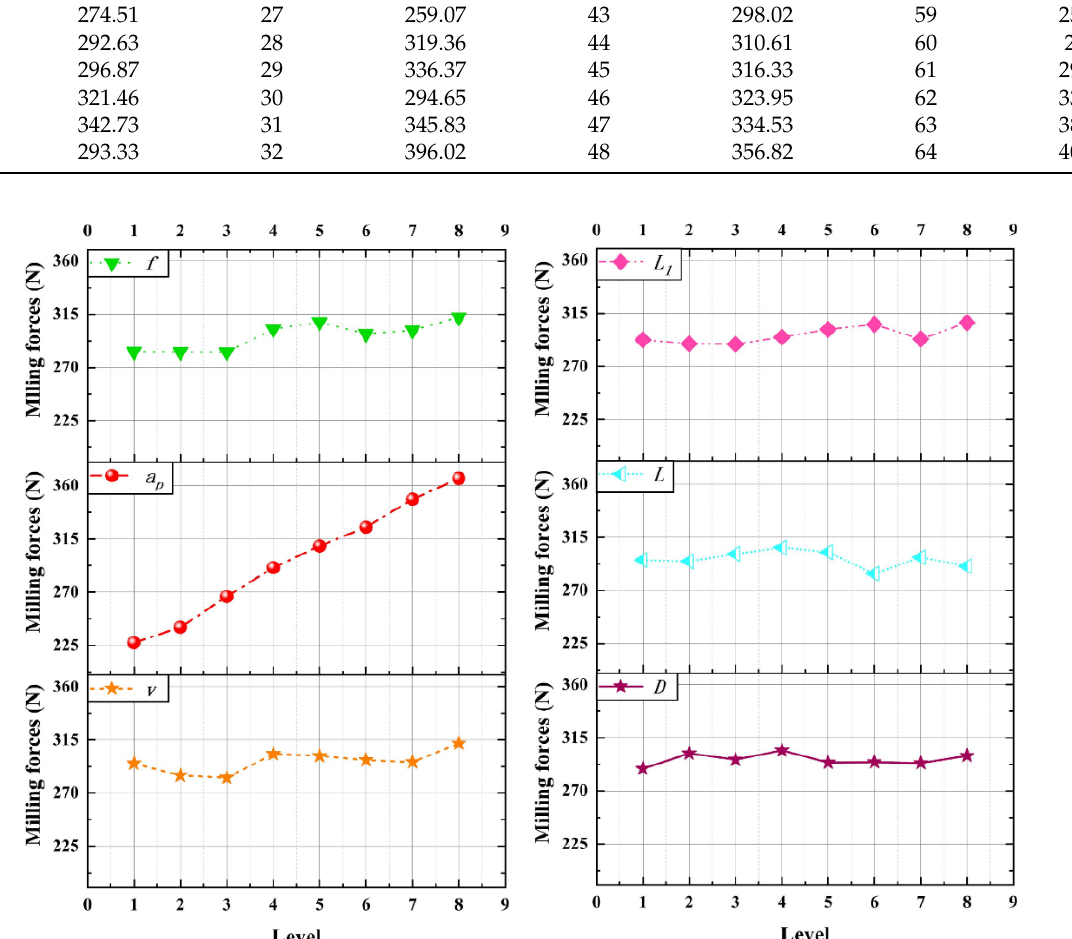
Figure 10. Milling force range analysis